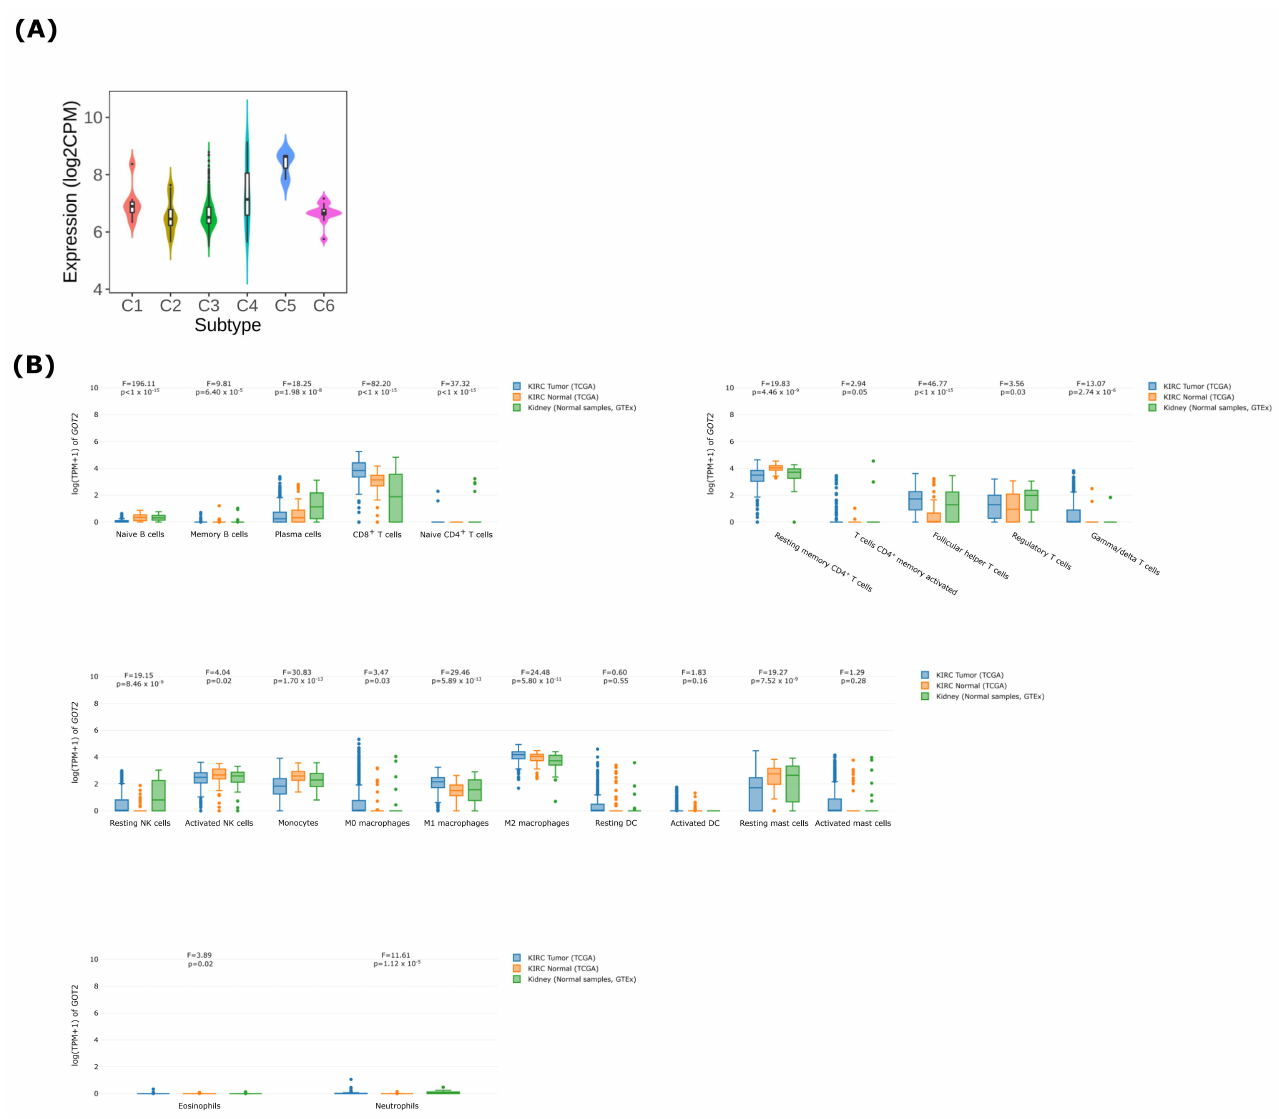
Figure 8. Association of GOT2 expression, with immune subtypes and immune cell infiltration.